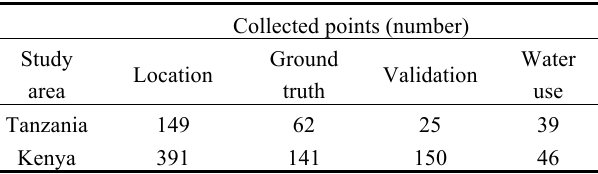
Table 2. Number of observation point collected referred to study areas